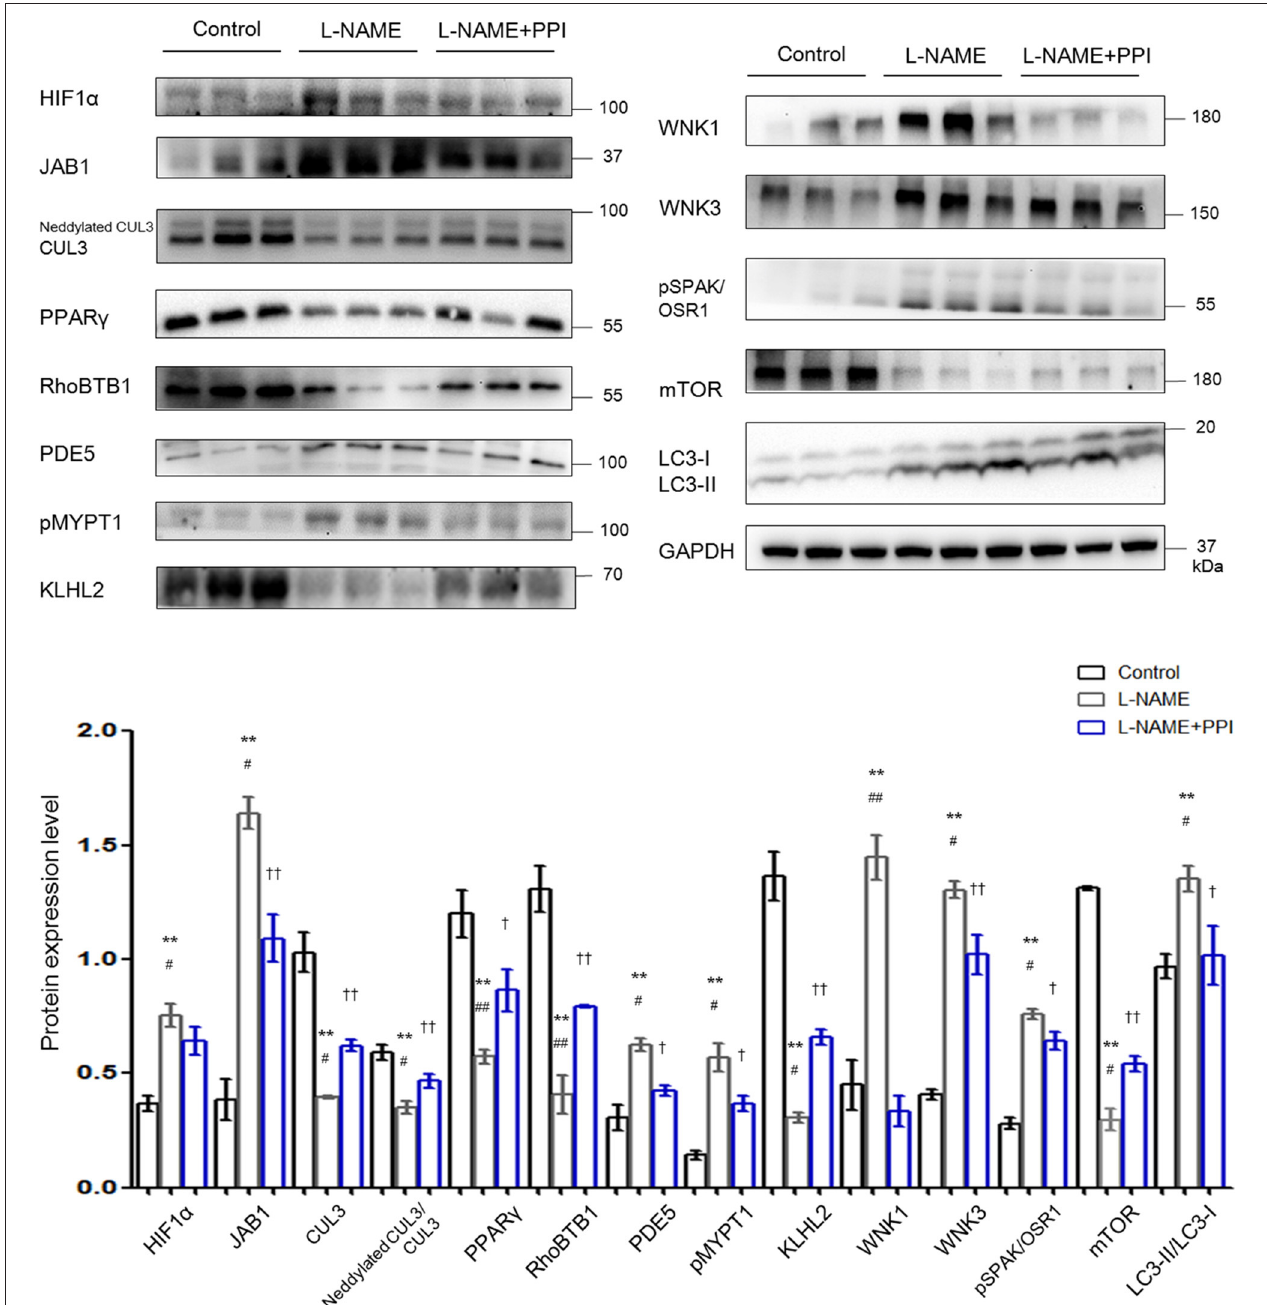
FIGURE 2 | Downregulation of CRL3 function caused accumulation of PDE5 and WNK kinases and increased RhoA/ROCK activity in the aortic tissues of pregnant L -NAME–treated mice. Protein levels were detected by Western blotting, including (1) hypoxia-inducible factor 1 α (HIF1 α ), member of the COP9 signalosome JAB1, CUL3 abundance and neddylation, and cardioprotective molecule PPAR γ ; (2) adaptor protein RhoBTB1 and its substrate PDE5 and the index of RhoA/ROCK activity phosphorylated MYPT1; (3) adaptor protein KLHL2 and its substrates including WNK1 and WNK3 and downstream phosphorylated SPAK/OSR1; and (4) autophagy markers mTOR and LC3-II/LC3-I. Expressions of these proteins in the aortic tissues were all statistically significant after normalization to GAPDH among control, L -NAME, and L -NAME + PPI group (ANOVA with Tukey post hoc analysis). Data are presented as the mean ± SEM. ** p < 0.01 compared between control and L -NAME group. # p < 0.05 and ## p < 0.01 compared between L -NAME and L -NAME + PPI group. † p < 0.05 and †† p < 0.01 compared between control and L -NAME + PPI